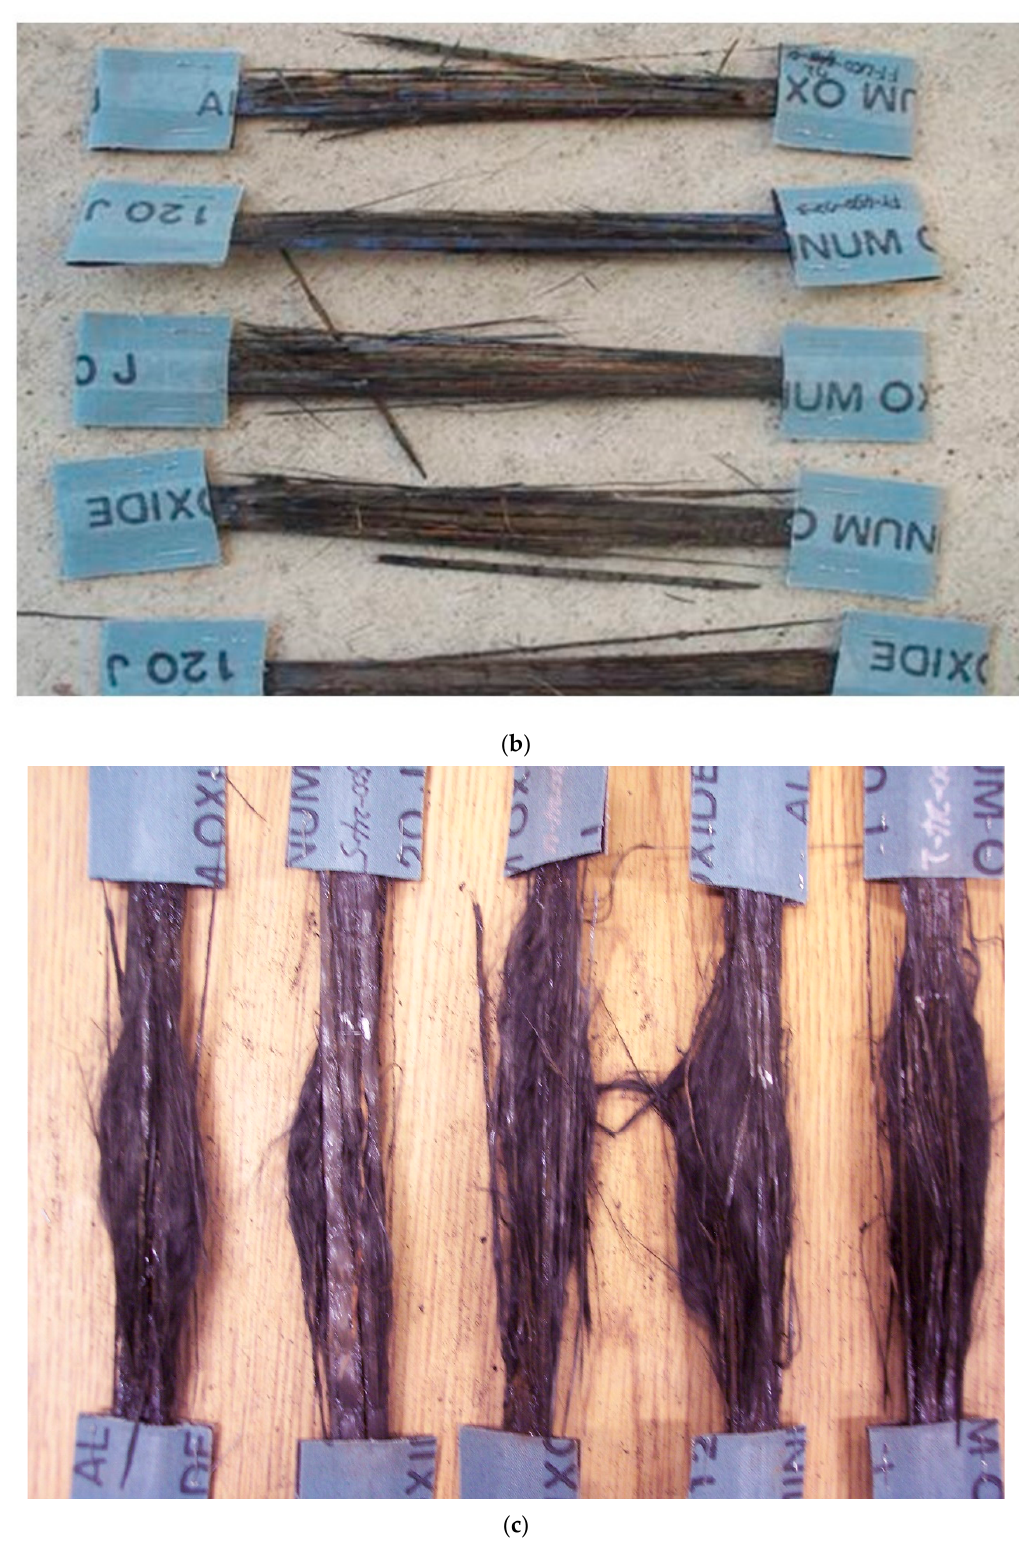
Figure 1. ( a ) Characteristic tensile failure within the gauge length. The figure on the top right shows a closeup of fracture surfaces; ( b ) Longitudinal splitting failure after exposure at 232 ◦ C; ( c ) Brooming mode of failure due to resin degradation after exposure at 260 ◦